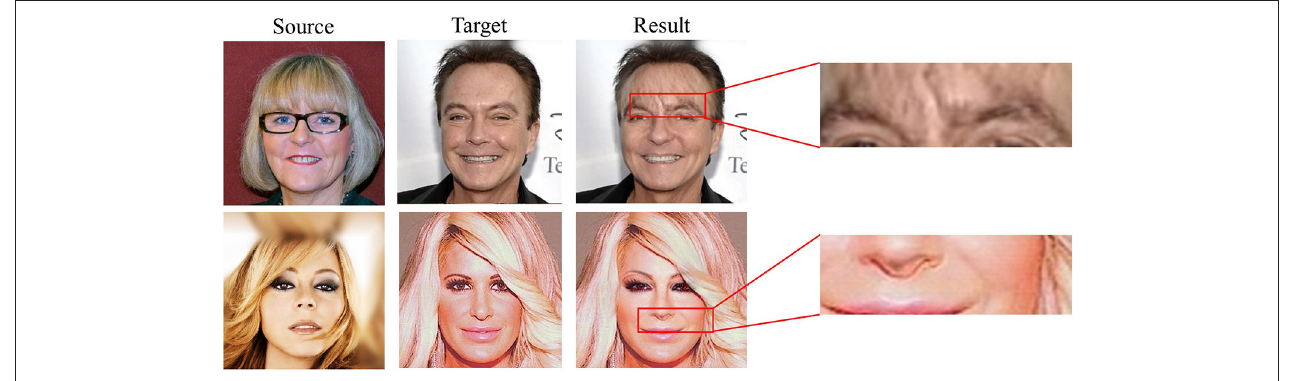
FIGURE 1 | Some abnormal results generated by FaceShifter (Li et al.,